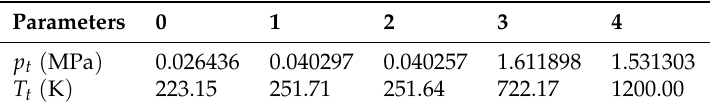
Table 4. Pressures and temperatures at different positions, 0: environment, 1: turbo fan inlet, 2: compressor inlet, 3: combustion chamber inlet, 4: turbine inlet. Parameters 0